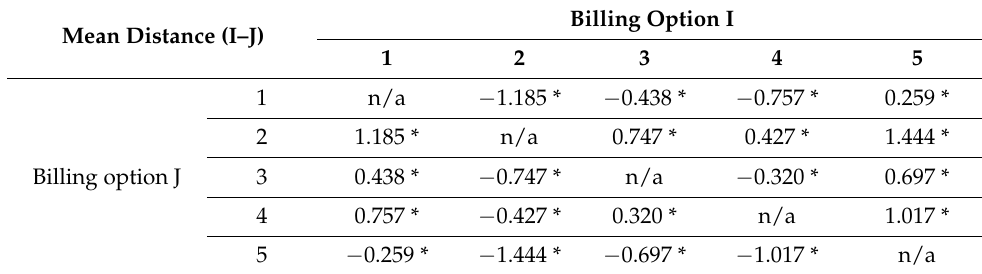
Table 5. Bonferroni-corrected post-hoc test of the billing options’ ratings—“mostly BEV users”. Mean Distance (I–J)